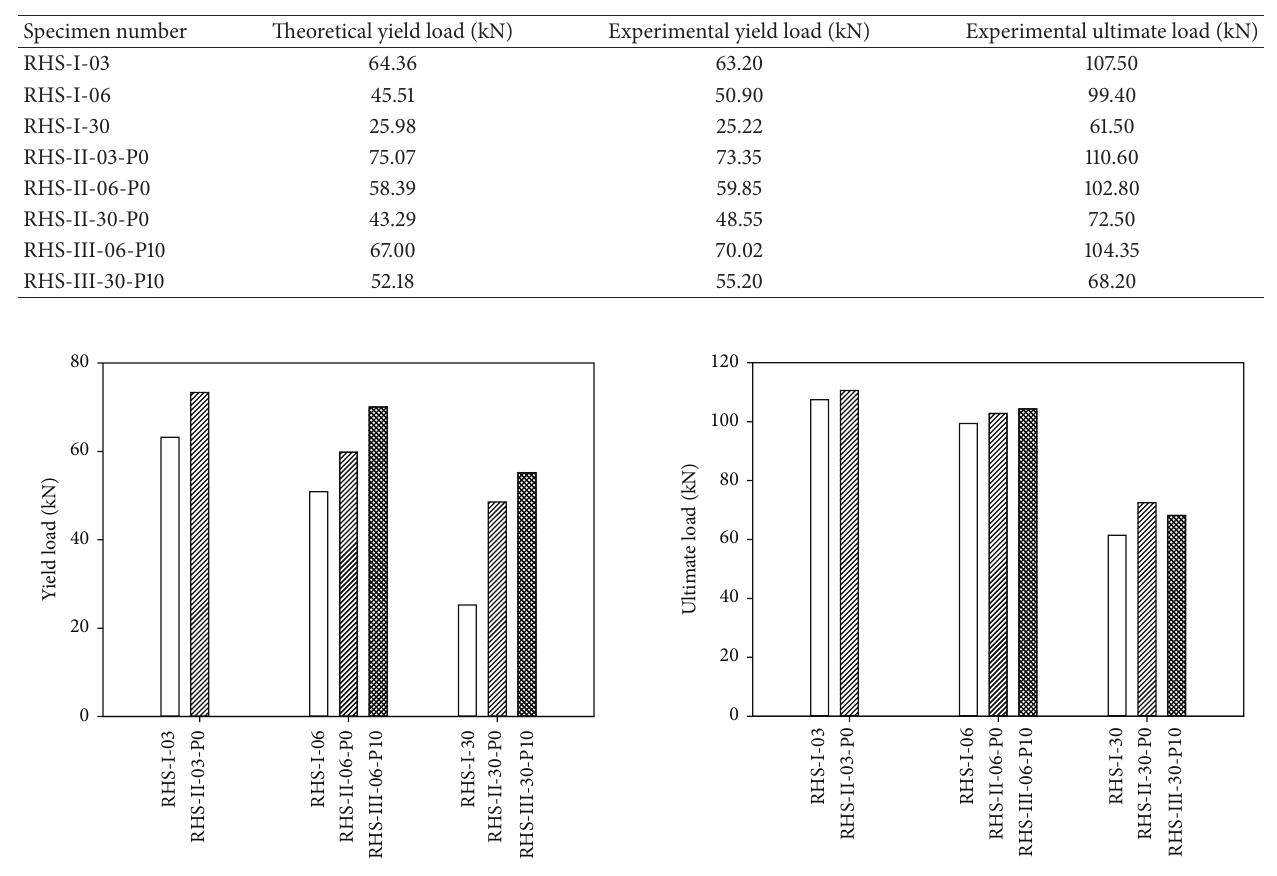
Figure 6: Experimental yield load. Figure 7: Experimental ultimate